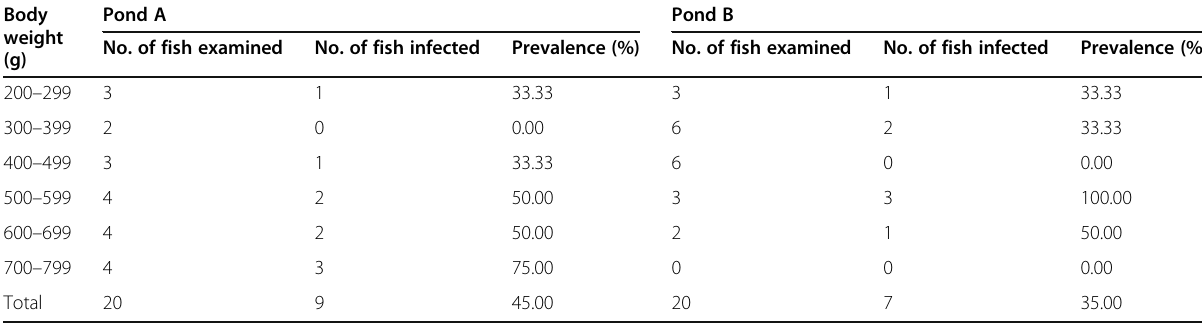
Table 9 Prevalence of parasites in relation to the body weight of cultured C. gariepinus Body